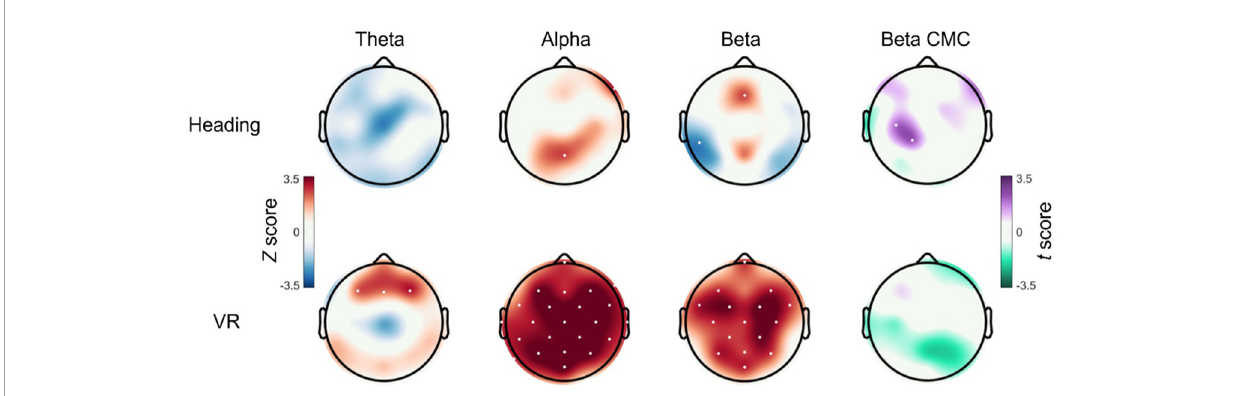
FIGURE3 Cortical and corticomuscular changes after an acute bout of heading. Topoplots displaying the EEG and CMC statistical difference maps between pre- and post-test for both the Heading (top row) and VR groups (bottom row) . For theta, alpha, and beta activity, non-parametric Wilcoxon signed-ranks tests were used to generate channel-wise Z scores, with red cortical areas indicating an increase in activity from pre- to post-test and blue cortical areas indicating a reduction in activity from pre- to post-test. For beta CMC, paired samples t -tests were used to generate channel-wise t-scores, with purple cortical areas indicating increased CMC from pre- to post-test and green cortical areas indicating decreased CMC from pre- to post-test. Channels that displayed a significant change from pre- to post-test are indicated with white